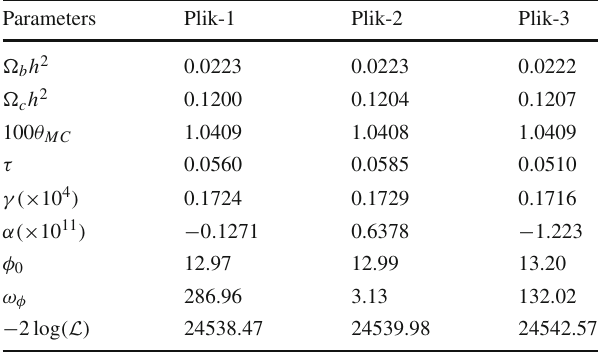
Table 3 Best-fit parameters and likelihood obtained for the candidates of the Plik-bin1 TTTEEE+lowT+lowE likelihood. First four are the (cid:2) CDM background parameters and the next four are the inflationary potential parameters. Final row gives the χ 2 values obtained by the candidates. Improvement in fit obtained are 10, 8.5, and 6 respectively for the candidates Plik-1, Plik-2, andPlik-3 Parameters